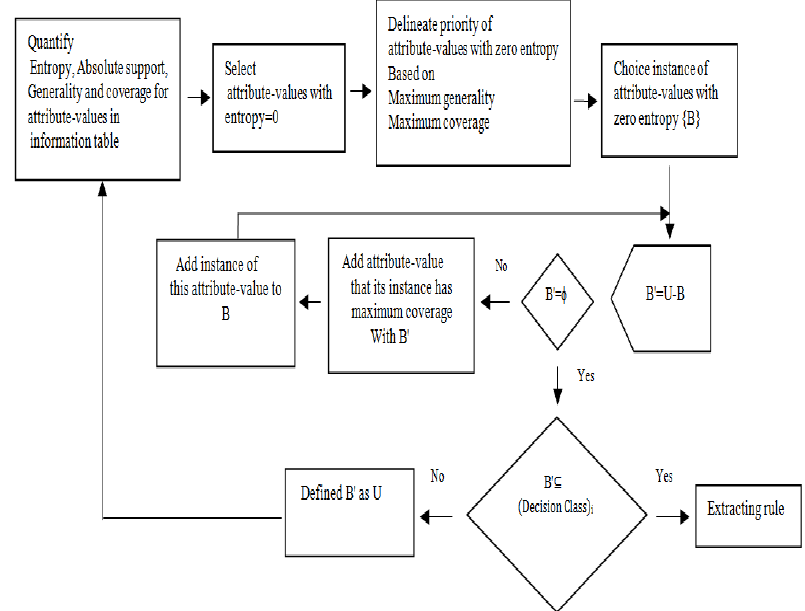
Figure 1. Granule tree algorithm for mining classification rules (Khamespanah et al.,